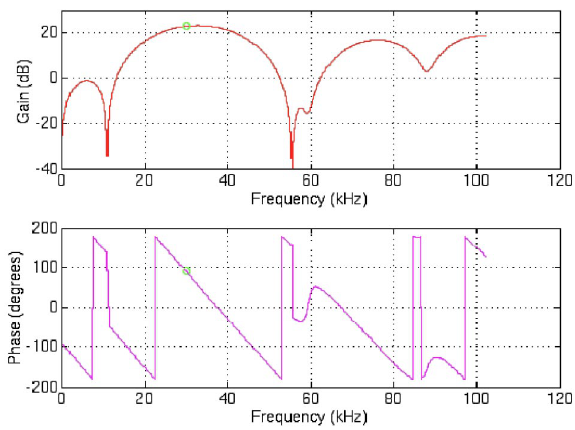
FIG. 17. (Color) Amplitude and phase response versus fre- quency response of a FIR filter with a peak at 30 kHz and a notch at 56